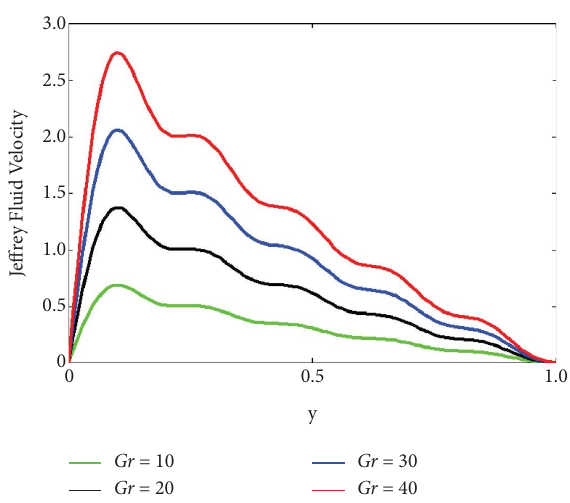
Figure 8: Te impact of diferent values of Gr on ψ ( y, t ) .